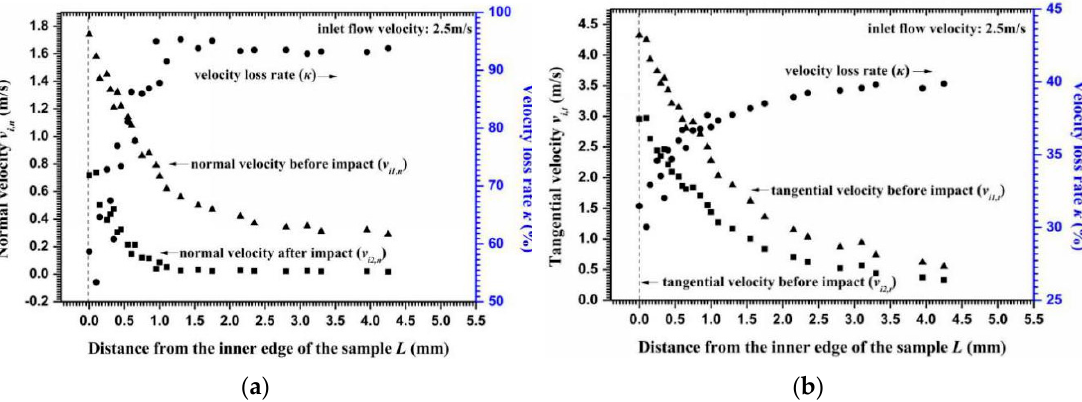
Figure 10. Velocity components of a particle in Particle Layer I along the radial surface. ( a ) Normal impact velocities; ( b ) Tangential impact velocities.